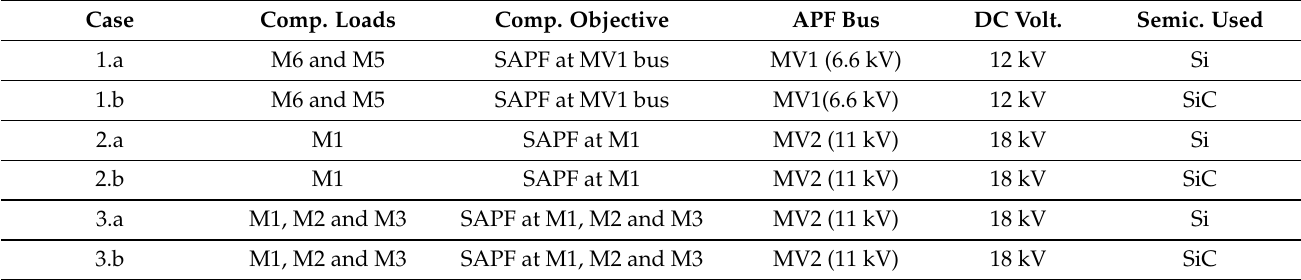
Table 2. Details of the case studies